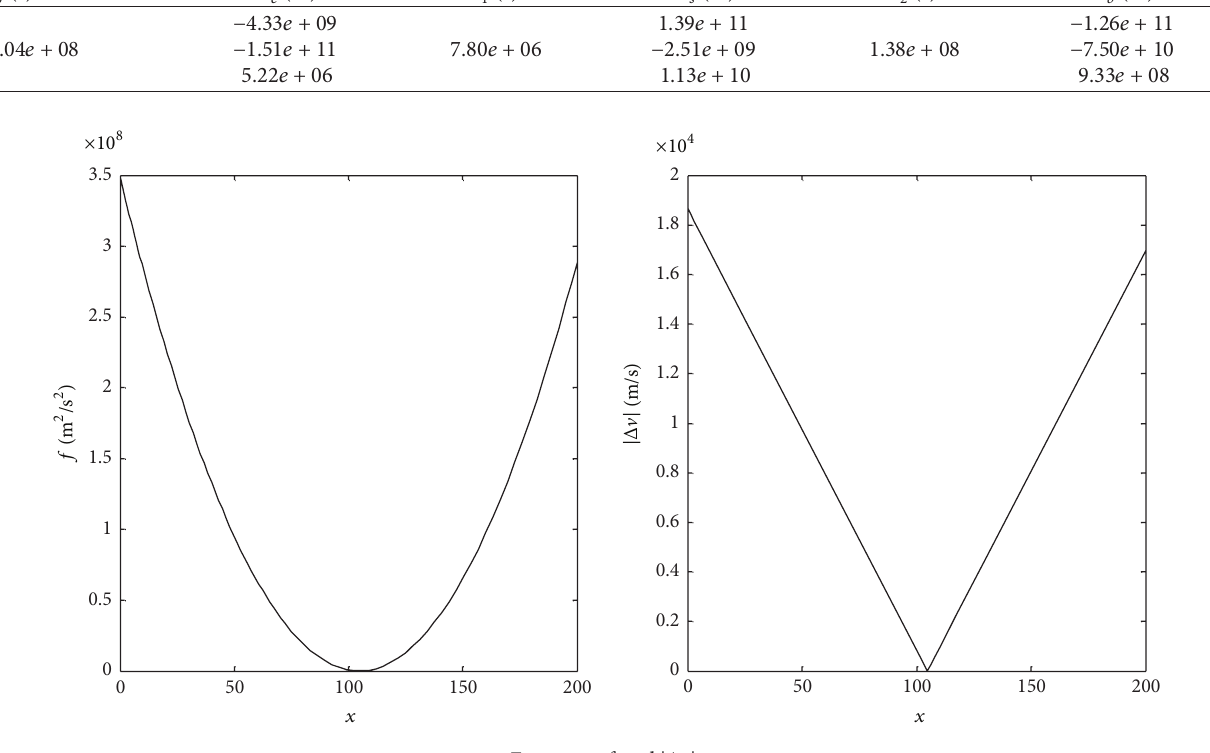
Figure 5: 𝑓 and |Δ V |